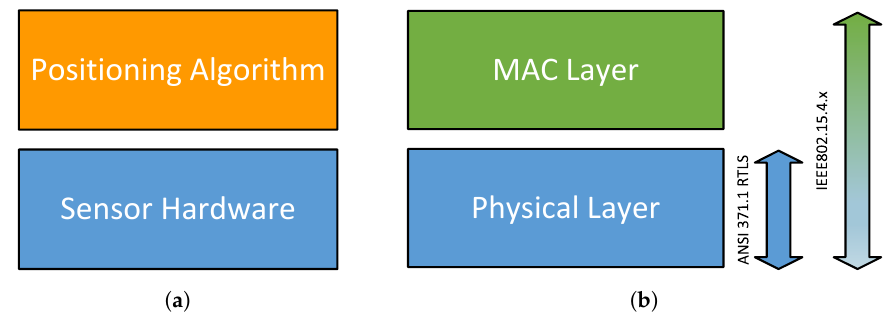
Figure 2. Localization system architectures. ( a ) Industrial and academic area, ( b ) ANSI371.1 RTLS and IEEE